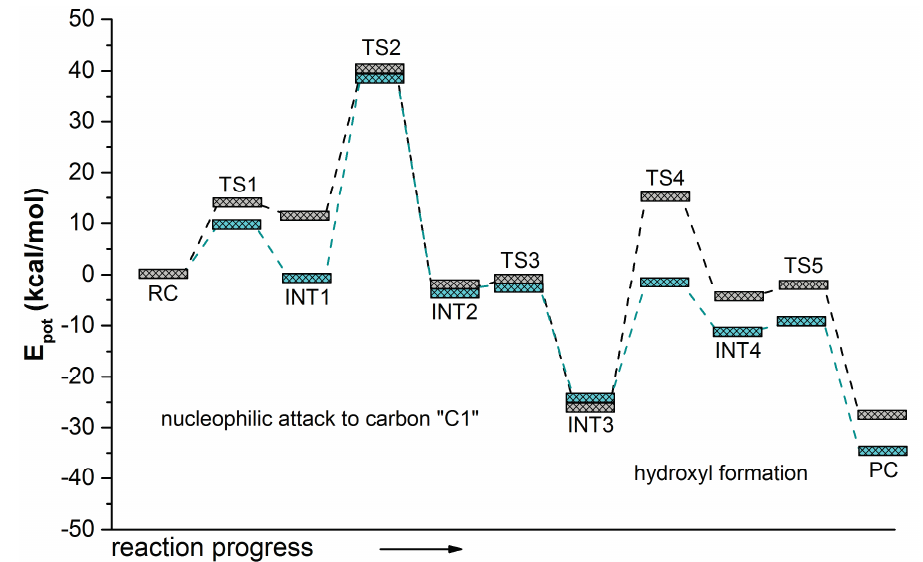
Figure 5. Potential energy profiles computed at the AM1 level for t-DPPO(1) hydrolysis catalyzed by sEH ( grey line ) and by Ser105Asp CALB ( green line ). The reaction corresponds to the catalytic attack on the C1 carbon of